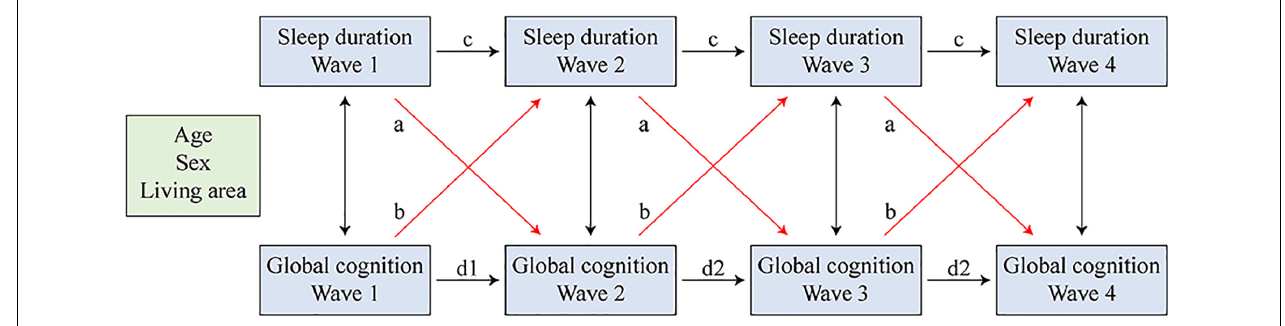
FIGURE 3 | Cross-lagged models of sleep duration and global cognition. Sleep duration and global cognition in all four waves were regressed on the covariates simultaneously. Paths that were constrained equal were marked with the same letter.